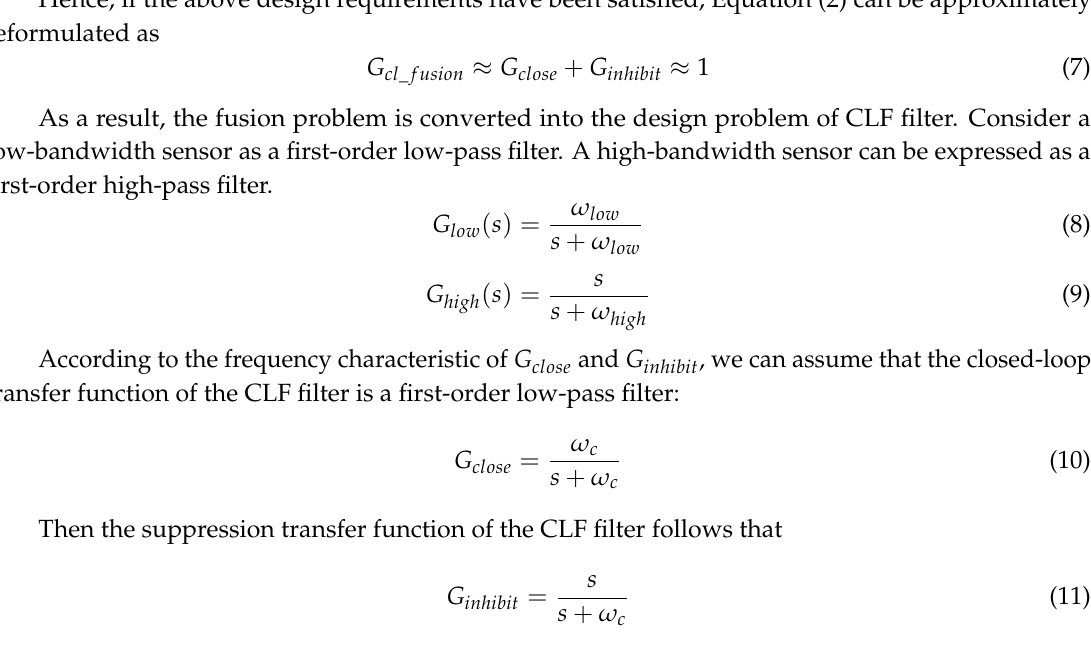
Figure 4. The result of multiplying two transfer functions when cut-off frequency differ greatly: ( a ) Low-pass product results; ( b ) High-pass product results.